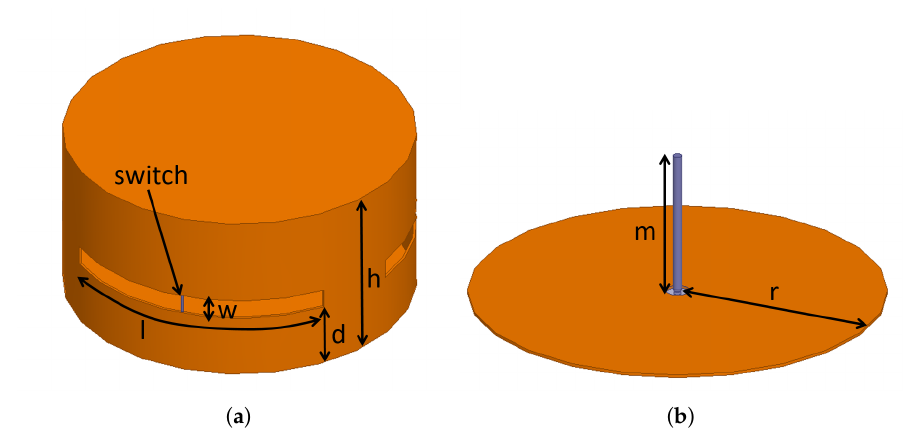
Figure 1. Proposed antenna geometry. ( a ) The external metallic cylinder with the slots, and ( b ) the internal monopole antenna used to excite the